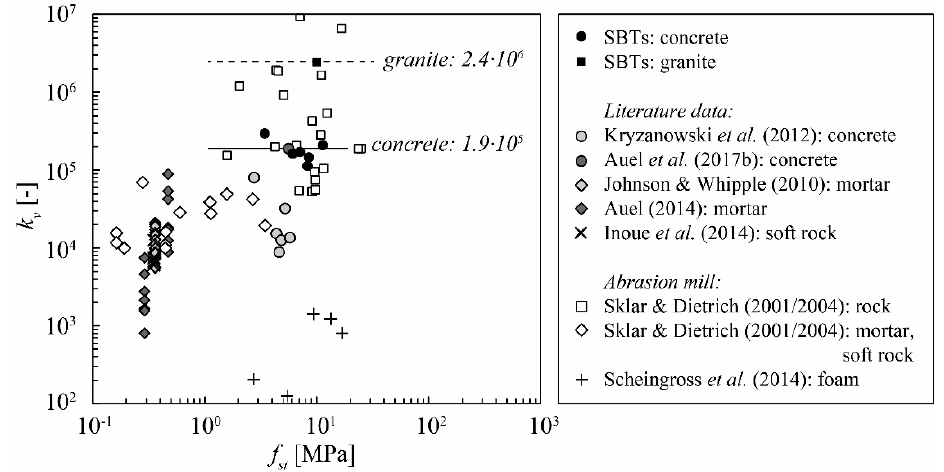
Figure 15. Abrasion coe ffi cient k v as a function of splitting tensile strength f st for the saltation abrasion model modified by [44] (SAMA).